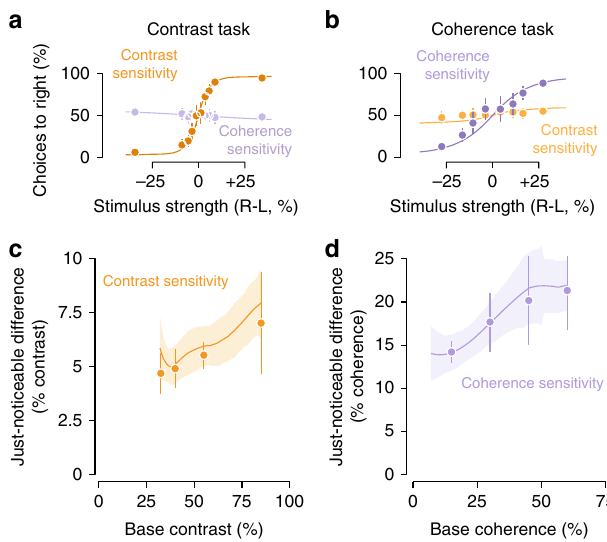
Fig. 2 Perceptual sensitivity to contrast and motion coherence and fi t of validation linking model. a Contrast task. The markers plot the average probability across observers and base stimulus strengths of indicating that the right dot patch had higher contrast or motion coherence while performing the contrast task, as a function of the difference in contrast (orange) or coherence (blue) between the two patches. Curves plot the predictions of the eight-area linking model using measurements made during passive viewing. These were fi t to each individual observer ’ s behavioral data with a fl exible readout, therefore fi tting each task separately. b Coherence task, conventions same as a . c Markers plot the just-noticeable difference for contrast during that task estimated from a Weibull function fi t for each base stimulus strength, averaged across observers. Curves indicate the average prediction of the eight-area linking model across observers. d Same as c for the coherence task. All markers indicate the mean and error bars the 95% con fi dence interval across observers. Curves indicate the mean model prediction across observers and shaded areas the 95% con fi dence intervals. Some error bars are hidden